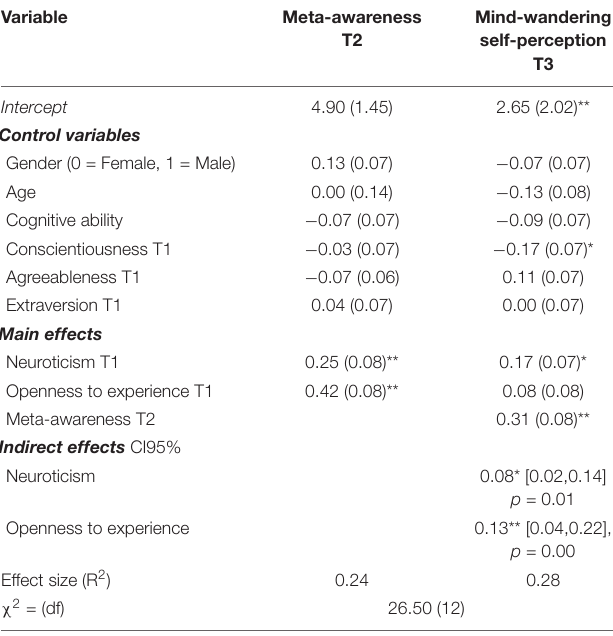
TABLE 2 | Structural equation modeling for personality, meta-awareness and mind-wandering self-perception.